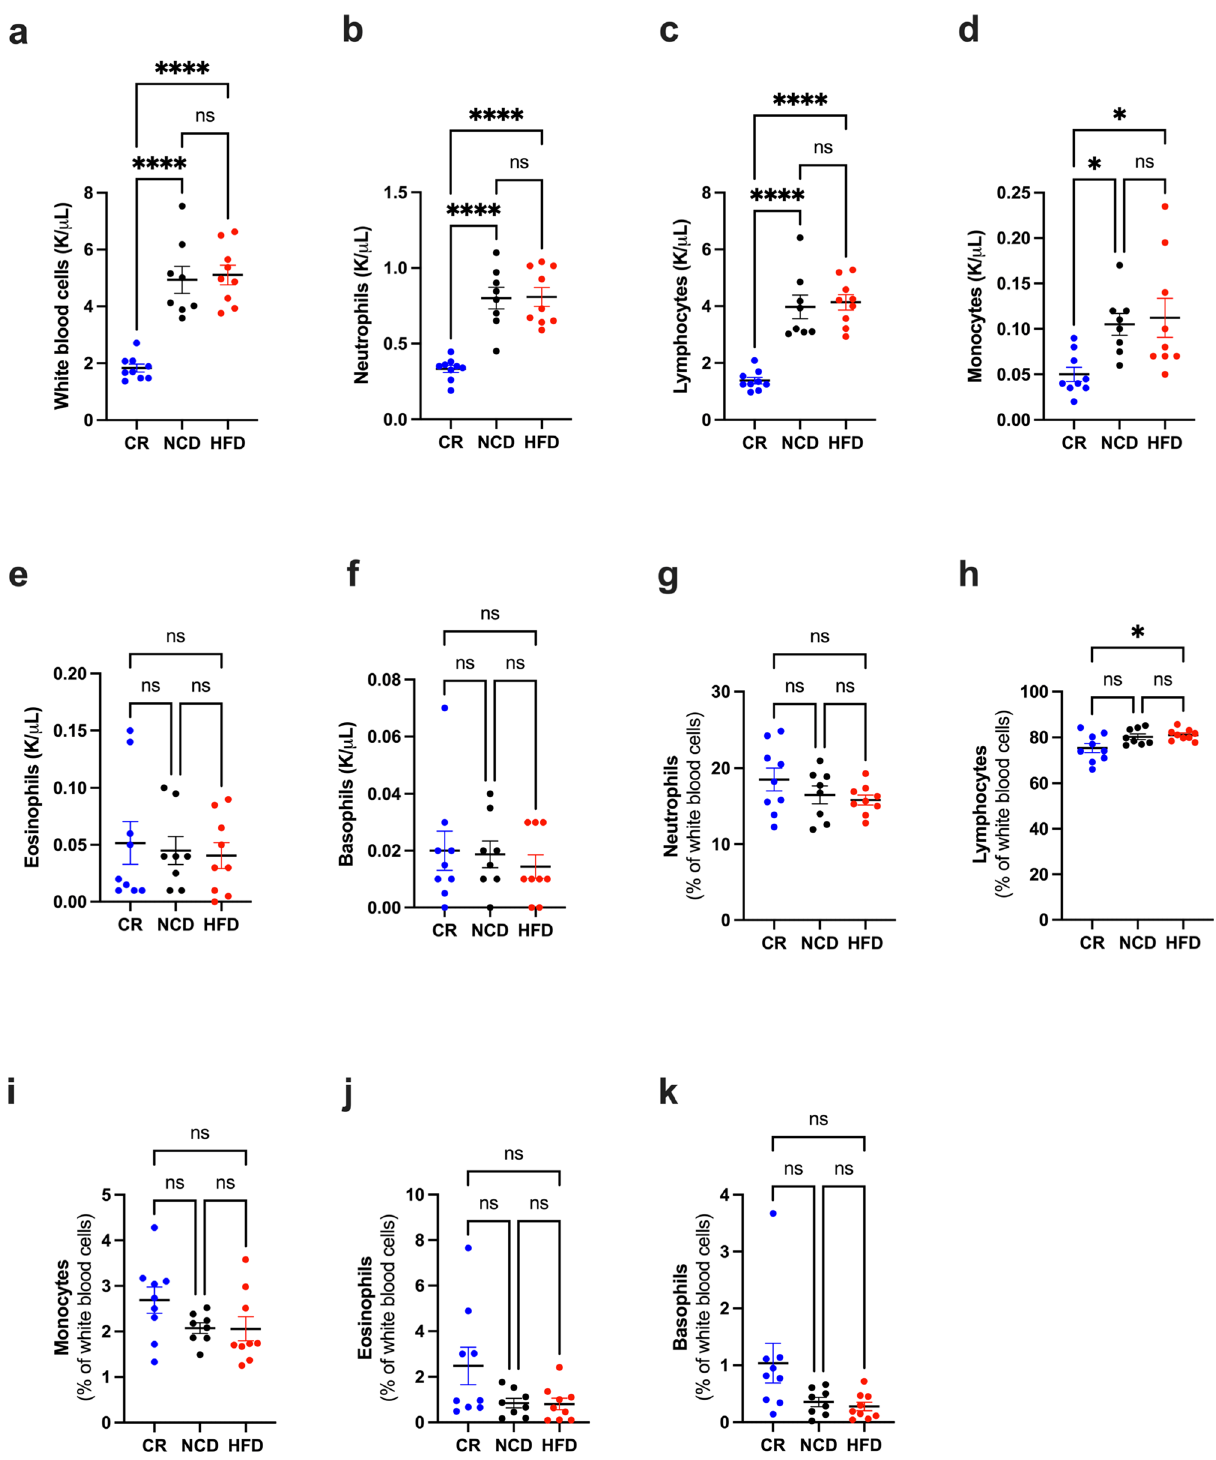
Figure 3. Peripheral blood cell counts at pre-tumour endpoint. ( a ) White blood cell count, ( b ) Neutrophil count, ( c ) Lymphocyte count, ( d ) Monocyte count, ( e ) Eosinophil count, ( f ) Basophil count, ( g ) %